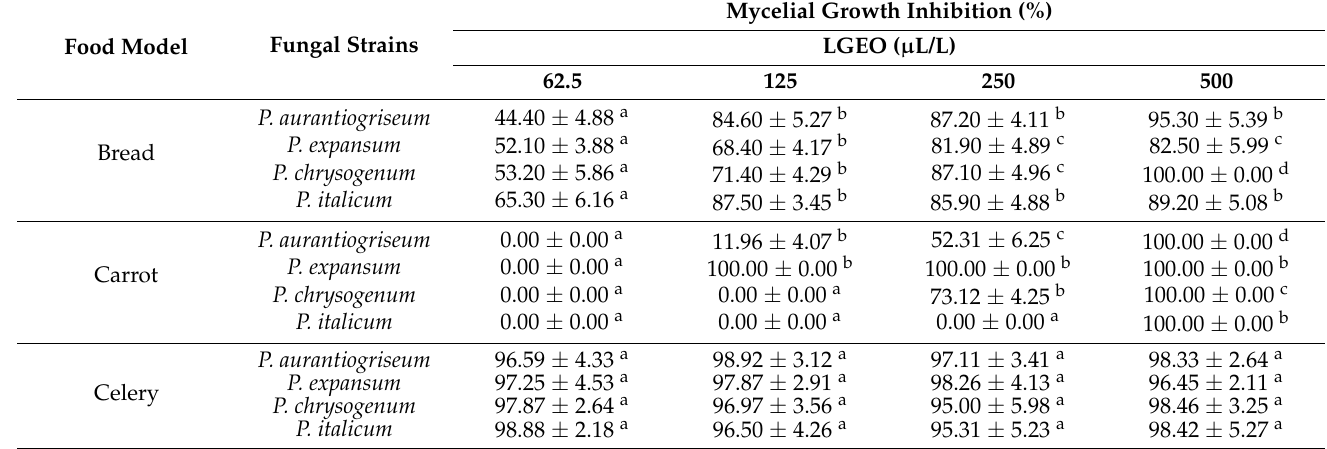
Figure 5. Antibacterial in situ activity of lemongrass essential oil against selected bacterial strains growing on diverse food model substrates (bread, carrot and celery samples). 1— Micrococcus luteus ; 2— Serratia marcescens ; ( A )—control sample; ( B )—62.5 µ L/L; ( C )—125 µ L/L; ( D )—250 µ L/L and ( E )—500 µ L/L. Table 5. Antifungal in situ activity of lemongrass essential oil against Penicillium spp. growing on selected food